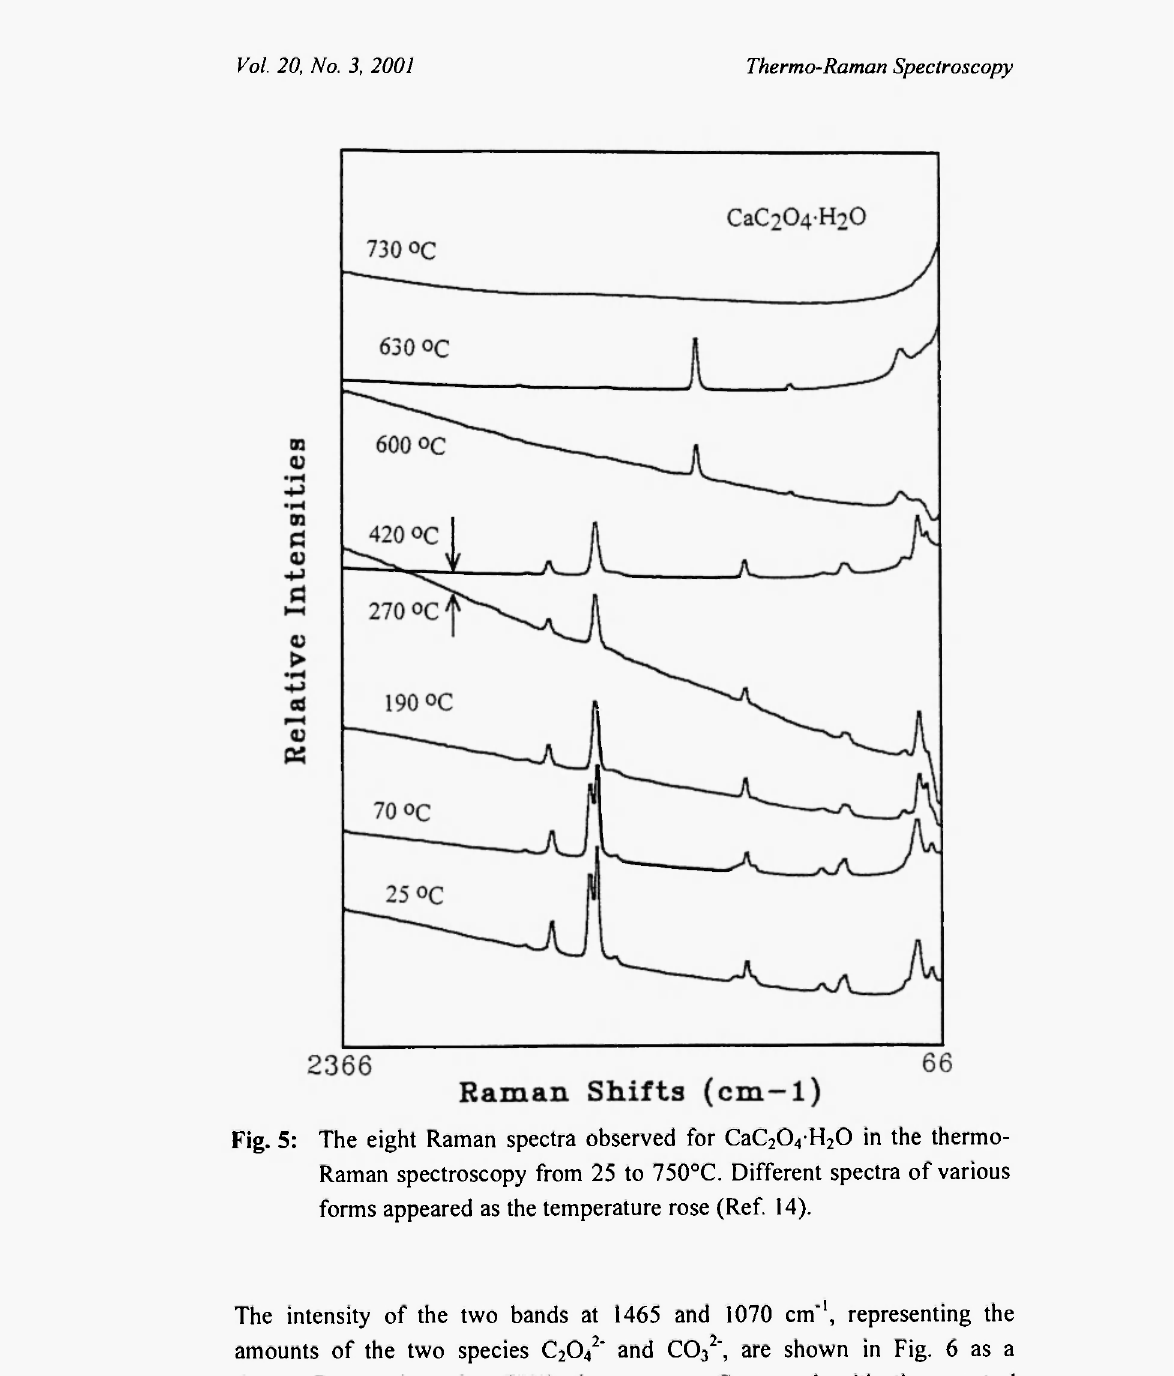
Fig. 5: The eight Raman spectra observed for CaC 2 0 4 H 2 0 in the thermo- Raman spectroscopy from 25 to 750°C. Different spectra of various forms appeared as the temperature rose (Ref.